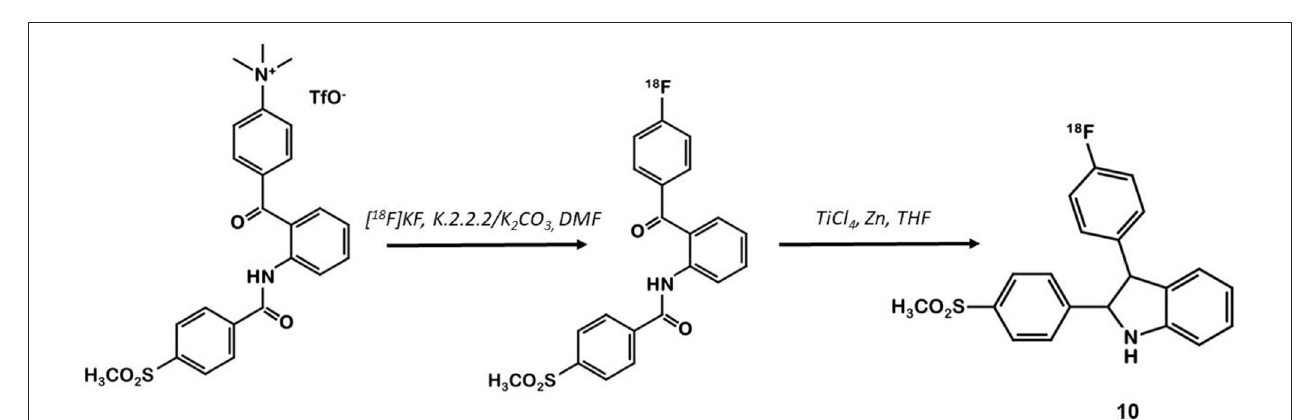
FIGURE 7 | Radiosynthesis of 18 F-10 via McMurry